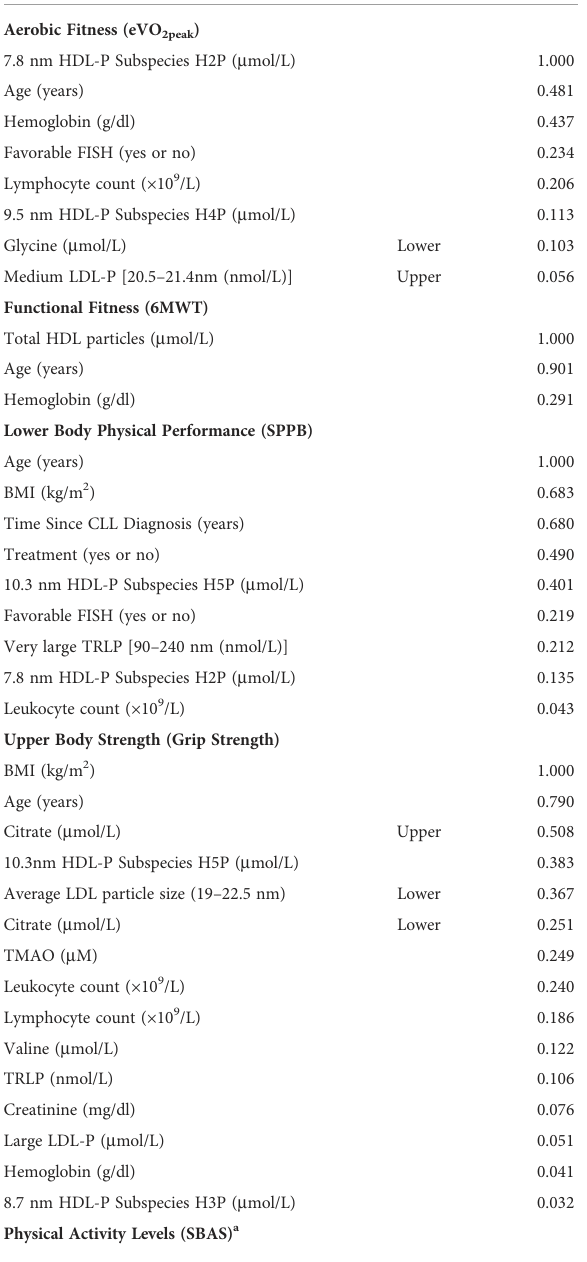
TABLE 5 Variable selection results of clinical and circulating factors for the odds of having dysfunctional physical characteristics. Cut